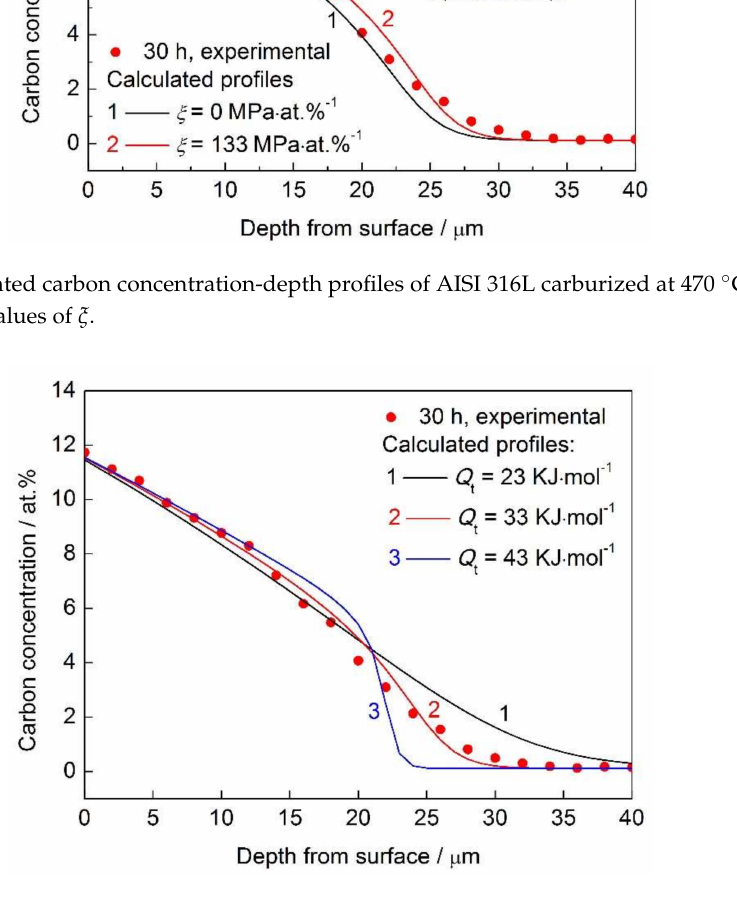
Figure 6. Influence of the detrapping activation energy ( Q t ) on carbon concentration–depth profiles of AISI 316L carburized at 470 ◦ C for 30